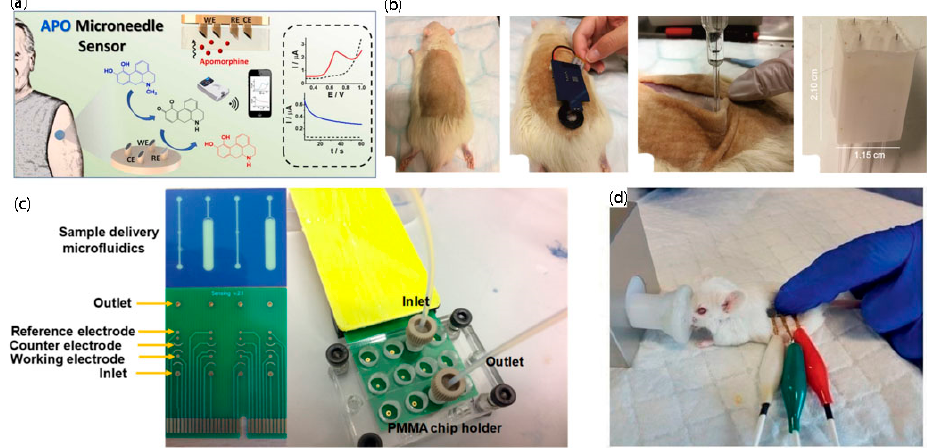
Figure 4. Application of an integrated chip and wearable sensor. ( a ) Usage model of APO sensor [53]; copyright 2021, Elsevier. ( b ) pH patch coupled with the potentiometric electronic board